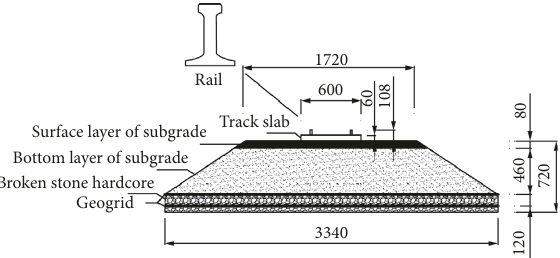
Figure 2: Schematic diagram of the embankment section (unit: